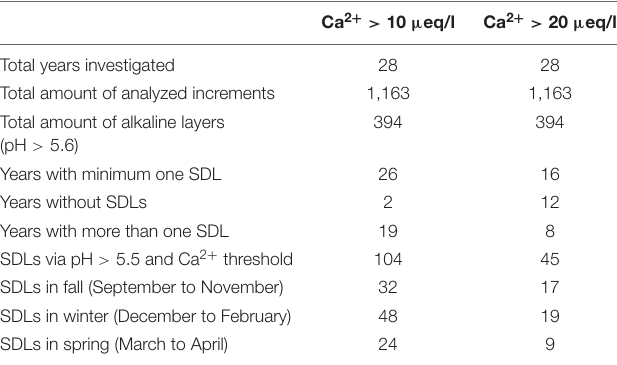
TABLE 3 | Overview and seasonality of the number of Saharan dust layers (SDLs) using different Ca 2 + thresholds of 28 years of snow pack data (1987–2017, missing data in 1988, 1989, and